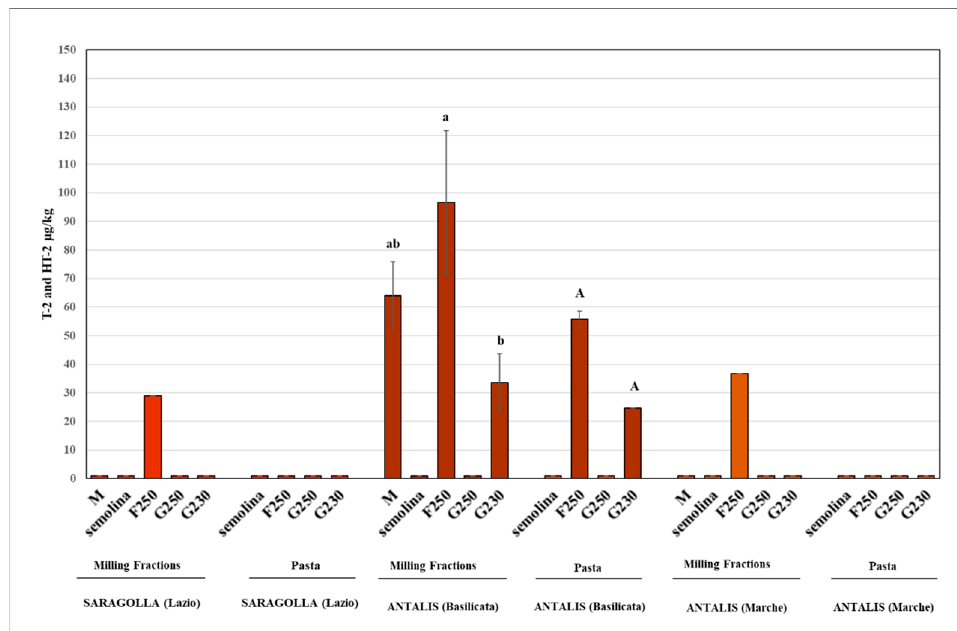
Figure 5. Group II: average values of the sum of the T-2 and HT-2 toxins in the micronised (M) and in the air-classified fractions (F and G) of the durum wheat samples that tested positive; different letters within each group indicate significant difference ( p < 0.05), n = 3; data without a letter indicate single values (F250).